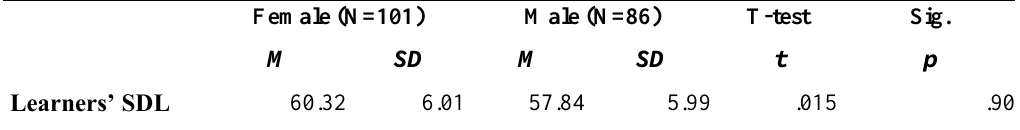
Table 3 | Results of Independent Sample T-Test of Female and Male Learners‟